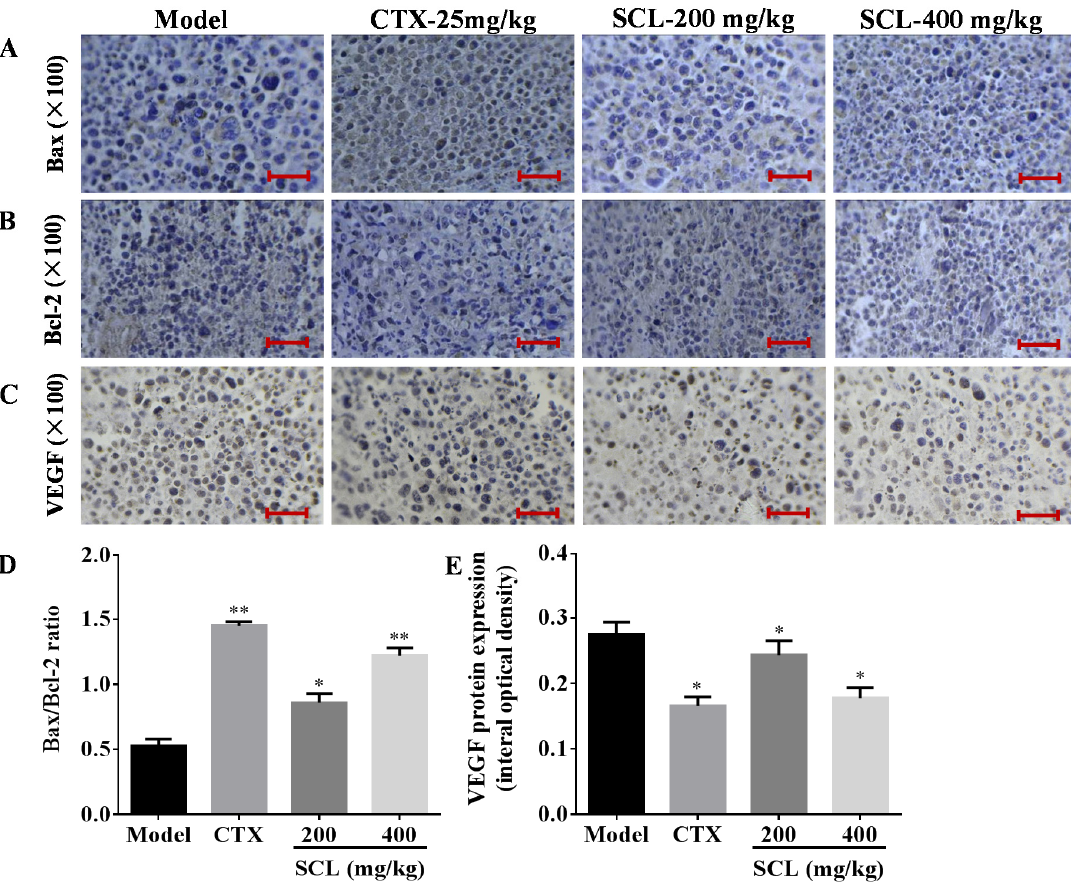
Figure 5. Effects of steamed C. lanceolata (SCL) on the expression of Bax, Bcl-2 and vascular endothelial growth factor (VEGF) ( A – E ). The protein expression was examined by immunohistochemistry. The images were analyzed by an Image-Pro plus system. All data were expressed as the mean ± standard deviation (SD). * p < 0.05, ** p < 0.01 vs. the model group. Bar: 25 μ m. n = 10.